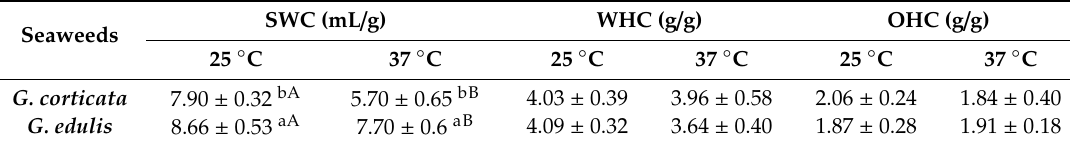
Table 6. Swelling capacity (SWC), water holding capacity (WHC) and oil holding capacity (OHC) of G. corticata and G. edulis